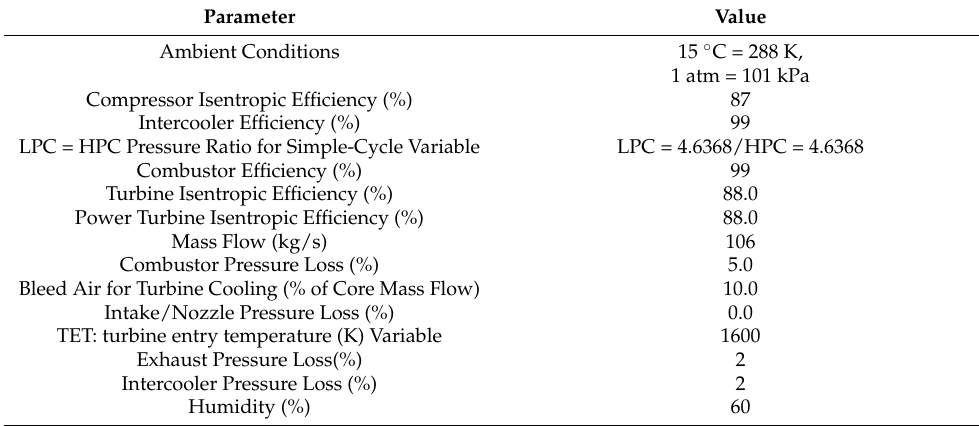
Table 2. Assumed parameters of the G.T.